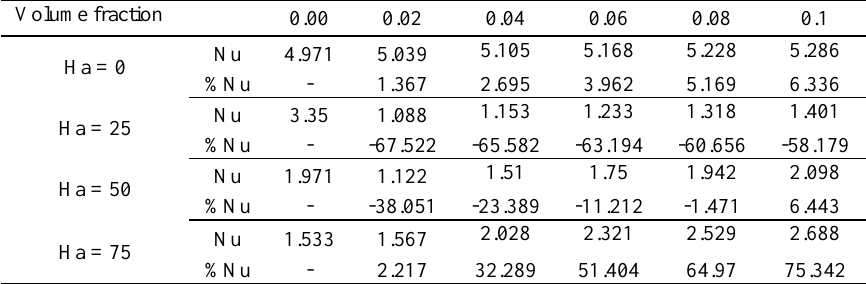
Table 6. Average Nusselt as a function of volume fraction and Hartmann number for